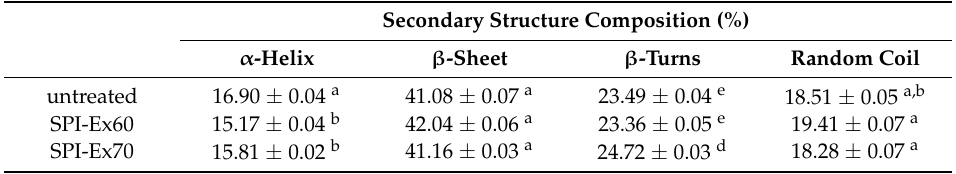
Figure 4. FTIR spectra ( A ) and fluorescence spectra ( B ) of SPI extracted from full-fat soybean flakes powder with and without extrusion treatment. Table 1. Effects of extrusion treatments on the secondary structure of